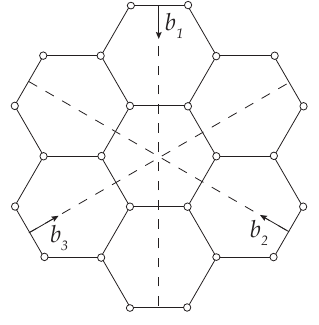
Figure 3. Burgers vectors of